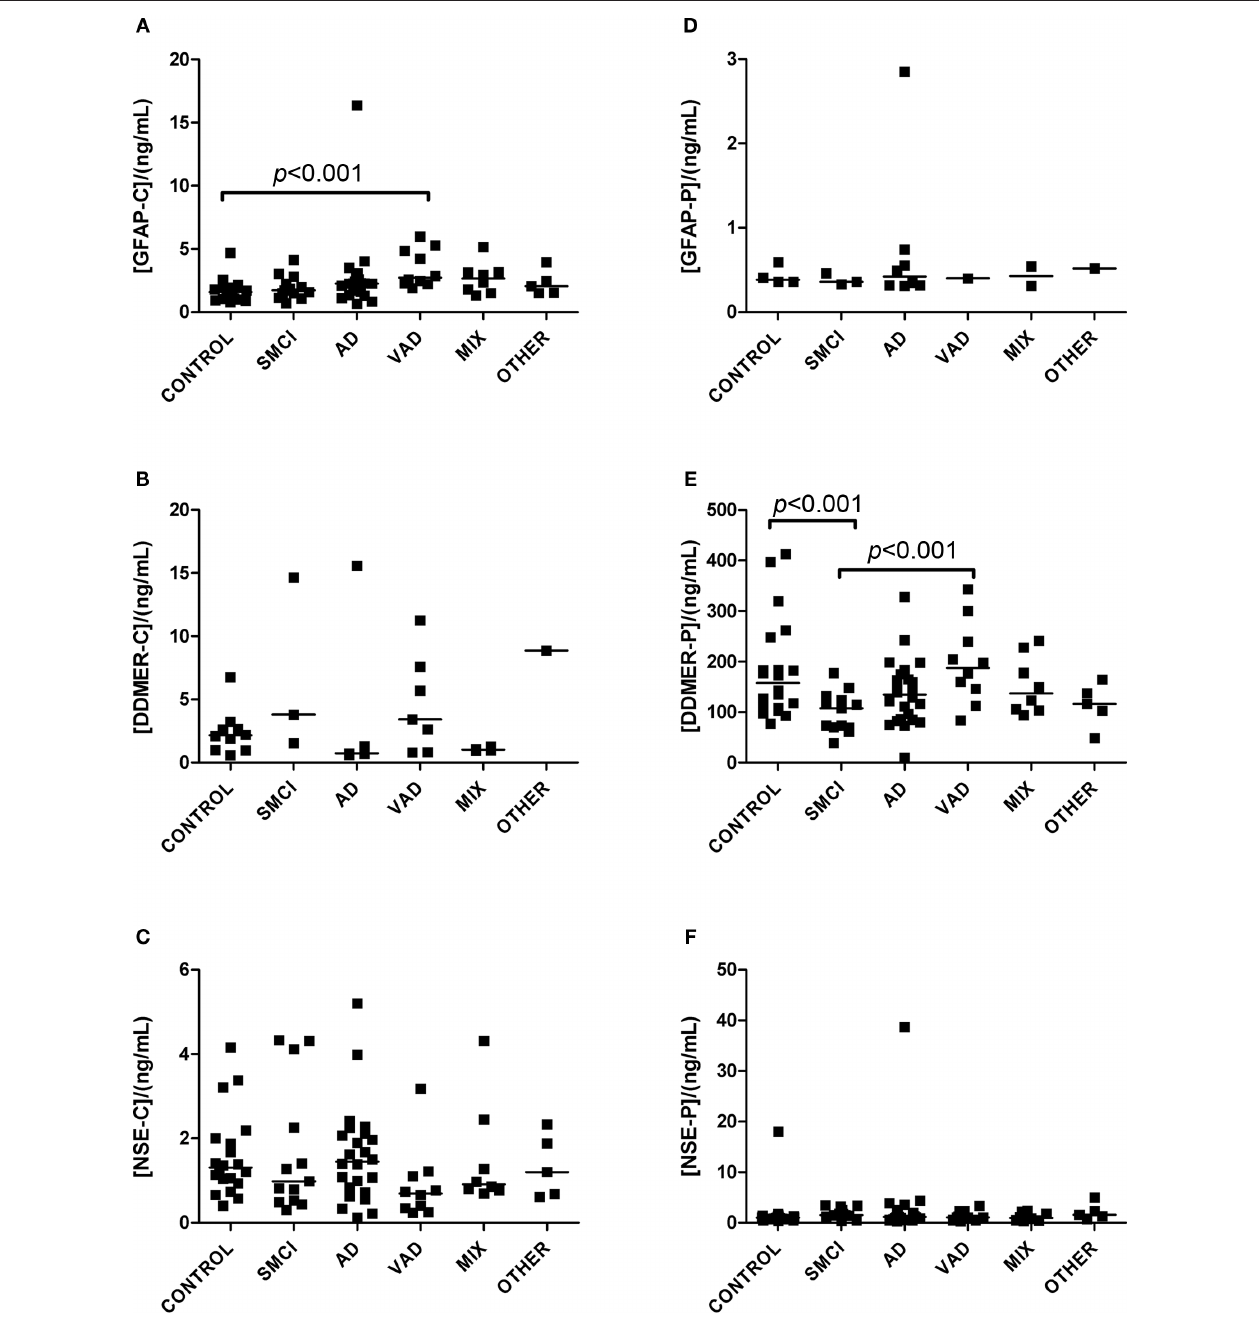
FIguRE 2 | Levels of analytes in plasma and CSF. (A–C) Show values obtained in CSF, and (D–F) display values obtained in plasma. Significant differences between diagnostic groups are shown by brackets. Straight lines indicate median